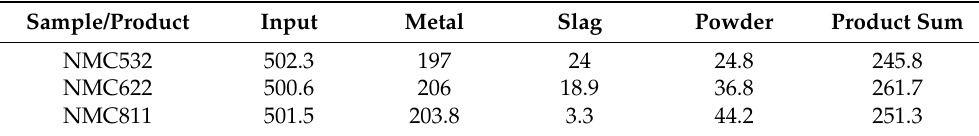
Table 2. Overview of the masses of the input material and the obtained products in each of the InduMelt experiments (mass,